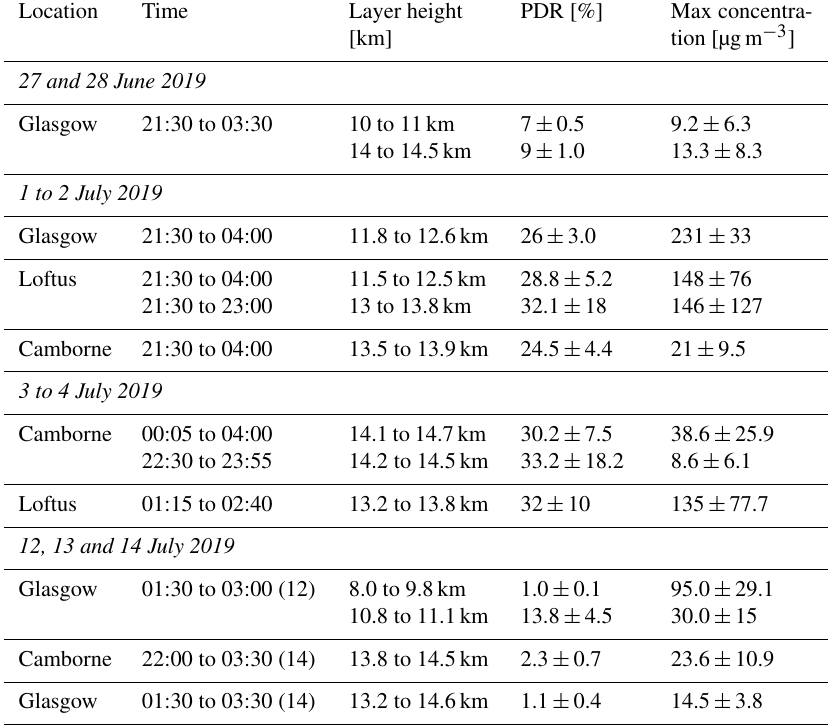
Table 5. Summary of lidar detections. There were marked changes in the PDR measured within the aerosol layers correlated to the dominant aerosol